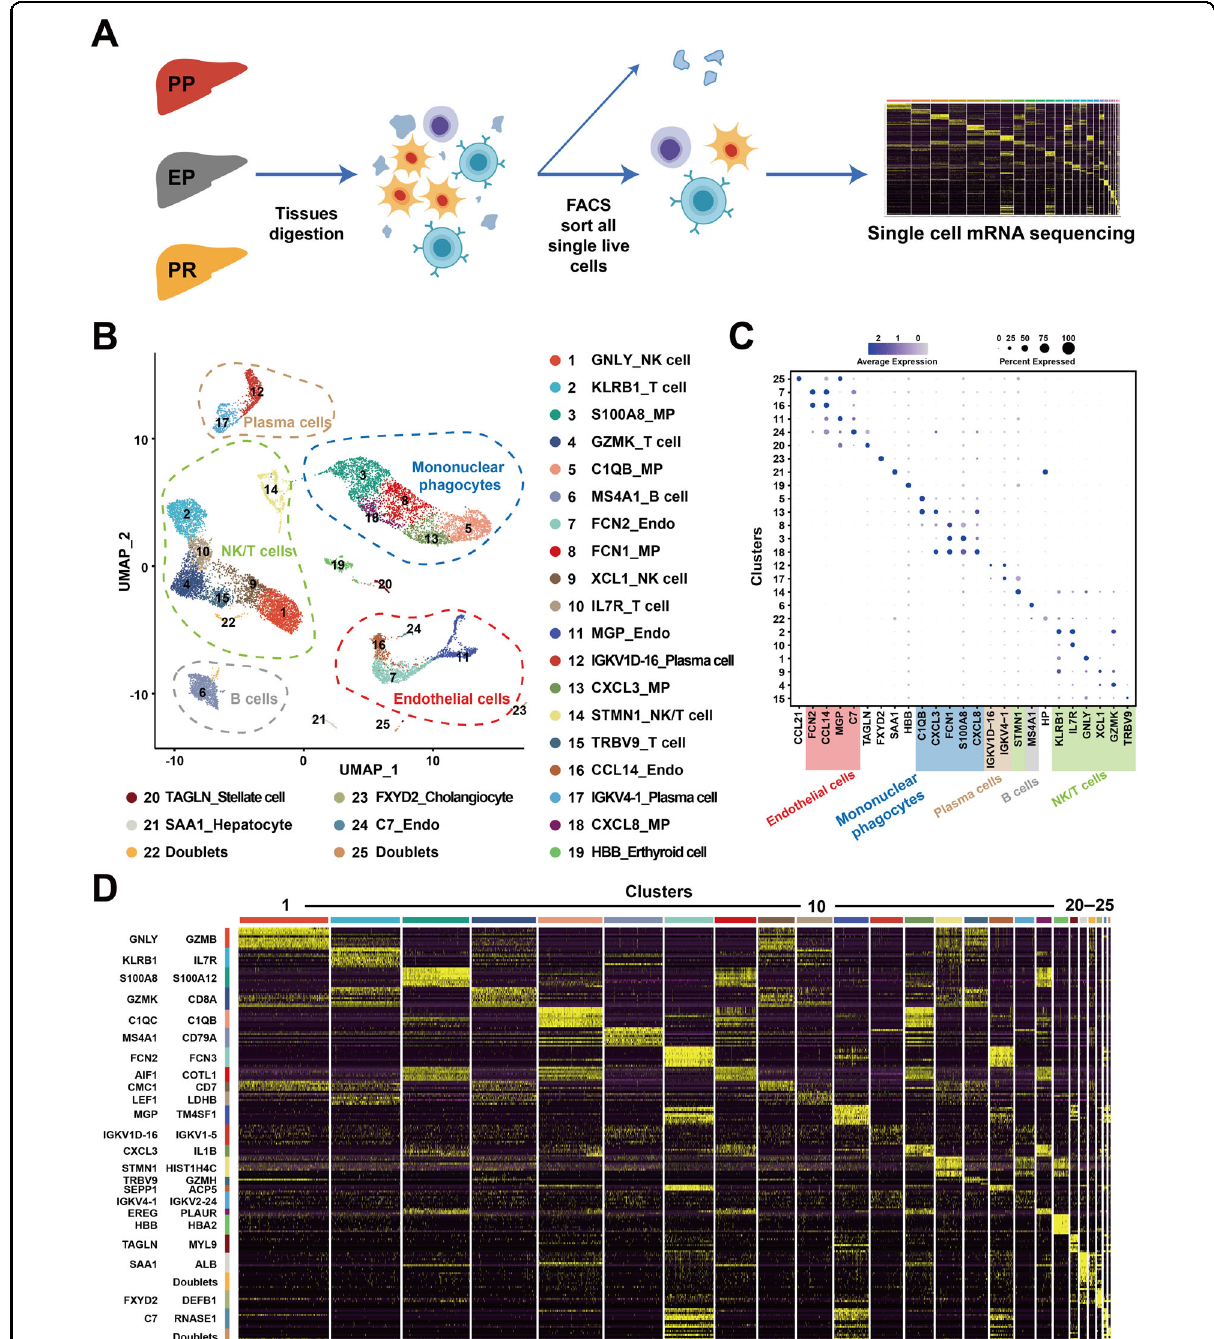
Fig. 1 Overview of scRNA-seq from samples in liver transplantation. A Work fl ow of tissue collection, sample processing, and data acquisition. Collect samples from three-time points, PP, EP, and PR, for tissue digestion. Next, sort live cells by FACS and construct cDNA libraries, then perform high-throughput sequencing and downstream analyses. B UMAP visualization of all cells (14,313) in 25 clusters. Each dot represents one cell, with colors coded according to the different clusters. Clusters are named by the most speci fi c and highly expressed genes. MP mononuclear phagocytes, Endo endothelial cells. C Dot plots showing the most highly expressed marker genes ( x -axis) of major cell types ( y -axis) in Fig. 1B. The color of the dots represents the level of gene expression while the size of the dot represents the percentage of cells expressing the gene. D Heatmap of top ten differentially expressed genes between different clusters. The line is colored according to clusters in Fig. 1B. Each cluster lists the top two genes shown on the